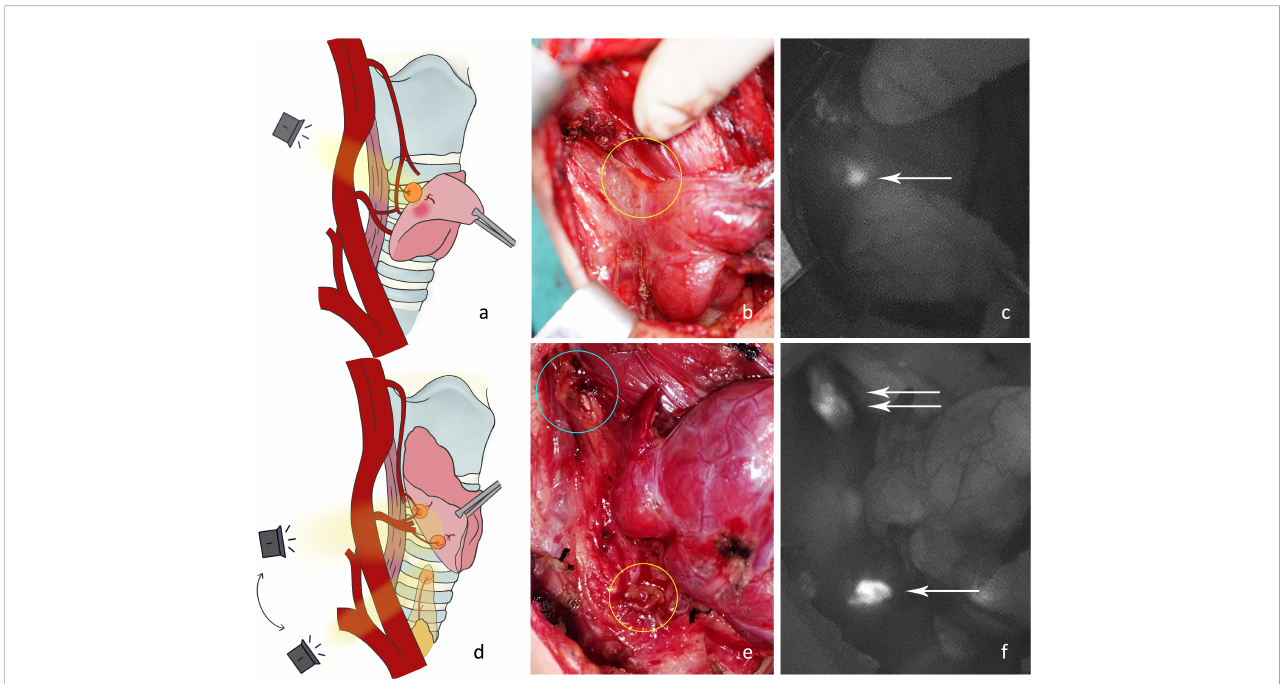
FIGURE 4 (A) The anterior branch of the superior thyroid artery was disconnected and the right superior parathyroid gland was detected. (B) The superior parathyroid gland on the dorsal side of the thyroid was dif fi cult to see under normal white light (yellow circle). (C) The NIRAF shows a type A gland (white arrow). (D) Part of the inferior vessels was disconnected and the right inferior parathyroid gland was imaged. (E) The type A gland (blue circle) and type C4 gland (yellow circle) are shown under normal white light. (F) The NIRAF shows a type A gland (white double arrow) and a type C4 gland (white arrow).